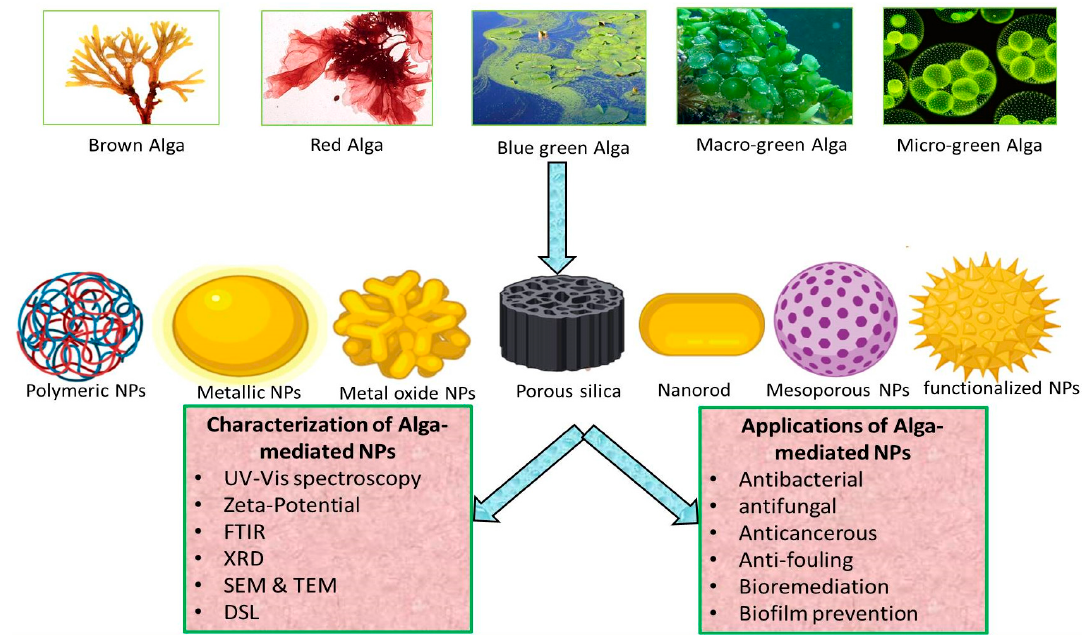
Figure 2. Graphical representation of algae-mediated biosynthesis, characterization and applications of NPs. Algae have long been exploited commercially and industrially as food, feed, additives, cosmetics, pharmaceuticals, fertilizer, and bioremediation